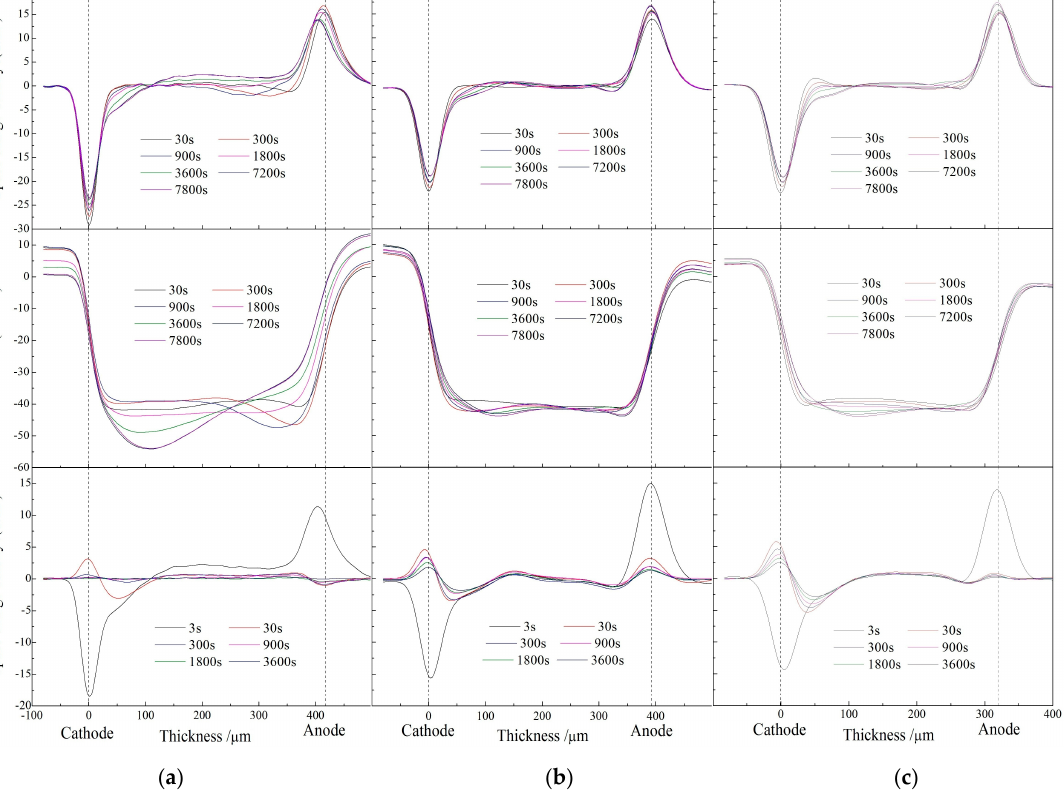
Figure 3. Space charge distributions at 60 °C in ( a ) XLPE, ( b ) XLPE-g-0.33wt%MAH, and ( c ) XLPE-g-0.41wt%MAH under applied DC electric field 40 kV/mm (upper panels) and in short-circuit (bottom panels). Electric field distributions across samples in polarization process are illustrated in middle panels.